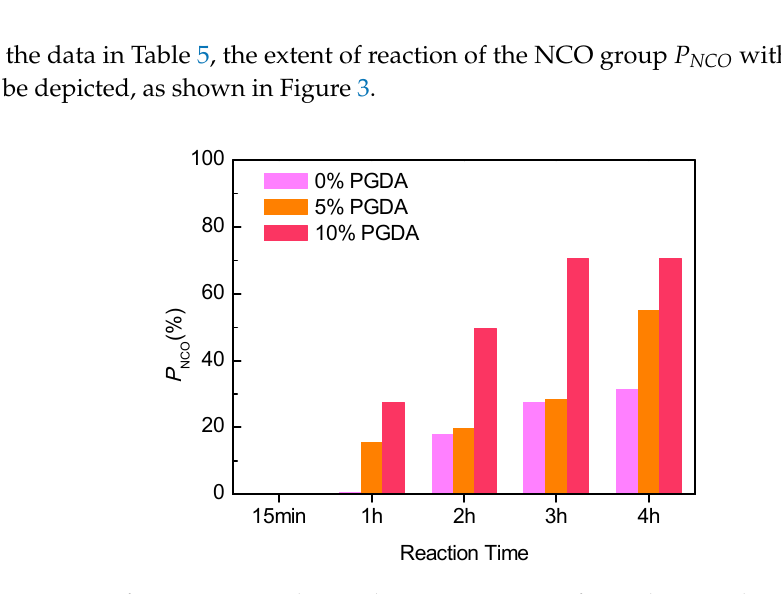
Figure 3. Extent of NCO reaction during the curing process of waterborne polyurethane coating (0%, 5%, 10% PGDA).